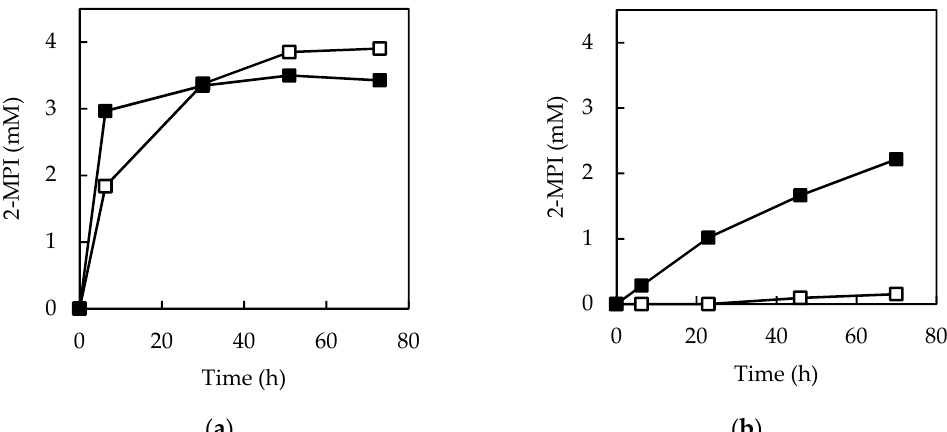
Figure 2. Hydrolysis of N -acetyl-2-MPI ( a ) and N -pivaloyl-2-MPI ( b ) using Arthrobacter sp. K5 cells. Closed squares; ( S )-2-MPI, open squares; ( R )-2-MPI. The reactions were performed at 30 °C in 2 mL of 100 mM potassium phosphate buffer (pH 7.0) containing 10 mM N -acyl-2-MPI and whole cells derived from 4 mL culture broth.